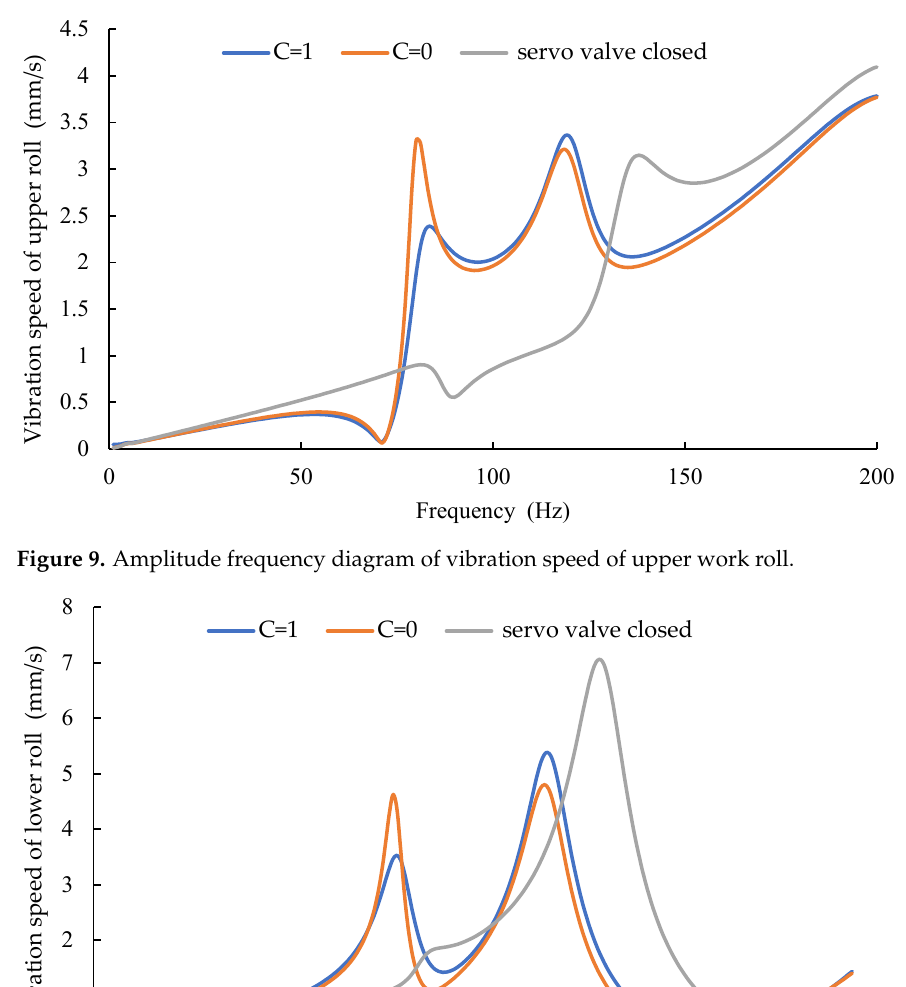
Figure 8. Rolling mill vibration spectrum at C = 1, f = 150 Hz.